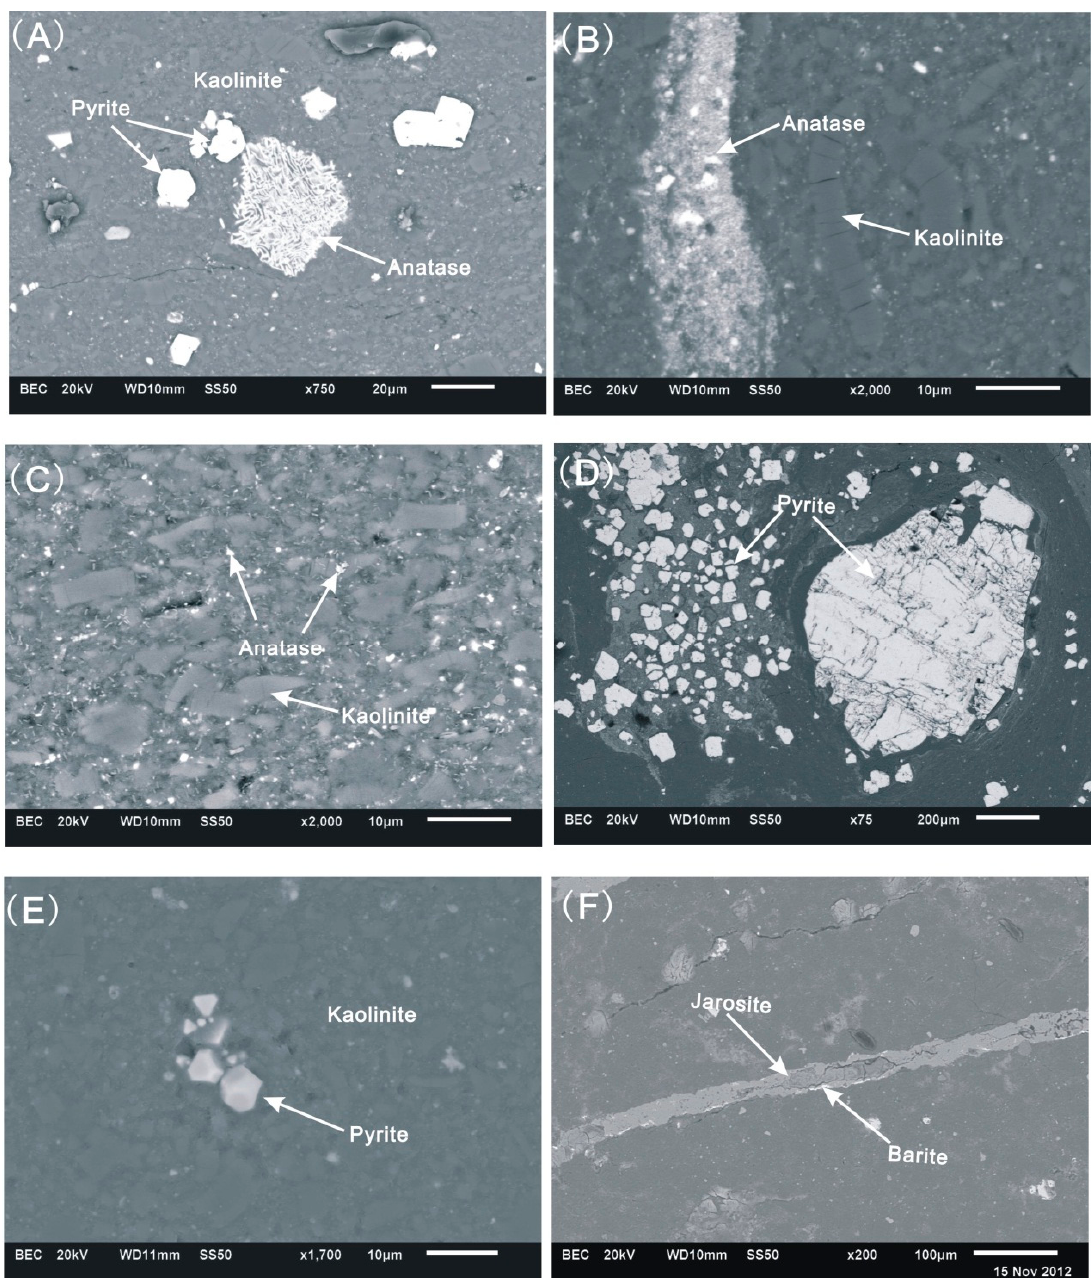
Figure 4. Back scattered images of minerals in the Zhongliangshan tuff: ( A ) kaolinite, pyrite and anatase in sample S140SE7-1; ( B ) kaolinite and anatase in sample S140SE7-8; ( C ) kaolinite and anatase in sample S140SE7-1; ( D ) pyrite in sample S140SE7-4; ( E ) pyrite and kaolinite in sample S140SE7-6; and ( F ) jarosite and barite in sample S140SE7-18.